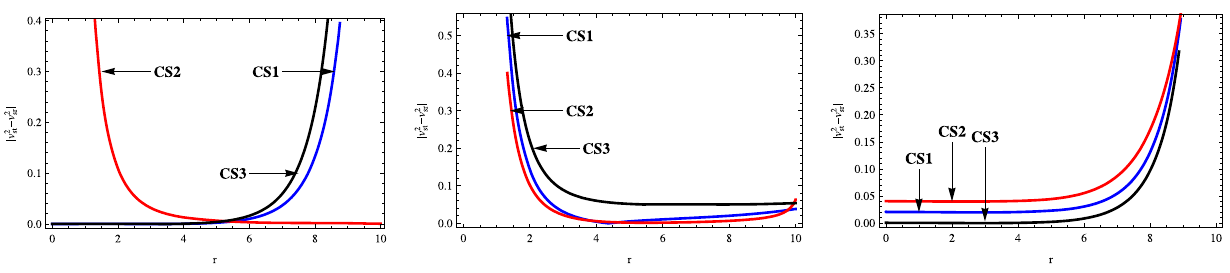
Fig. 15 Variations of v 2 st − v 2 sr versus r (km) with the numerical values of A , B and C from Tables 2, 3 and 4 respectively